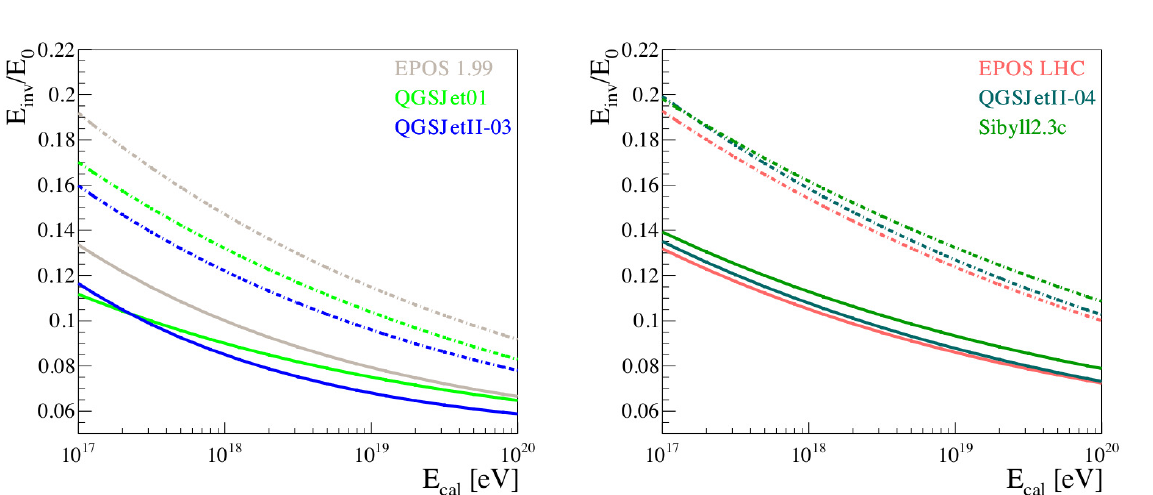
Figure 1. Average invisible energy fraction as a function of E cal calculated with Monte Carlo simulations using the hadronic interaction models tuned with LHC data (right) and the models developed before the LHC data were available (left). The predictions for proton and iron primaries are shown with solid and dashed lines, respectively. The simulations were performed using the CORSIKA code for the models EPOS 1.99 and QGSJ et II-03 [12, & references therein] and with the AIRES code for QGSJ et 01 [13, & references therein]. For the models tuned with the LHC data EPOS LHC, QGSJ et II-04, and Sibyll2.3c we used the CONEX code [14, & references